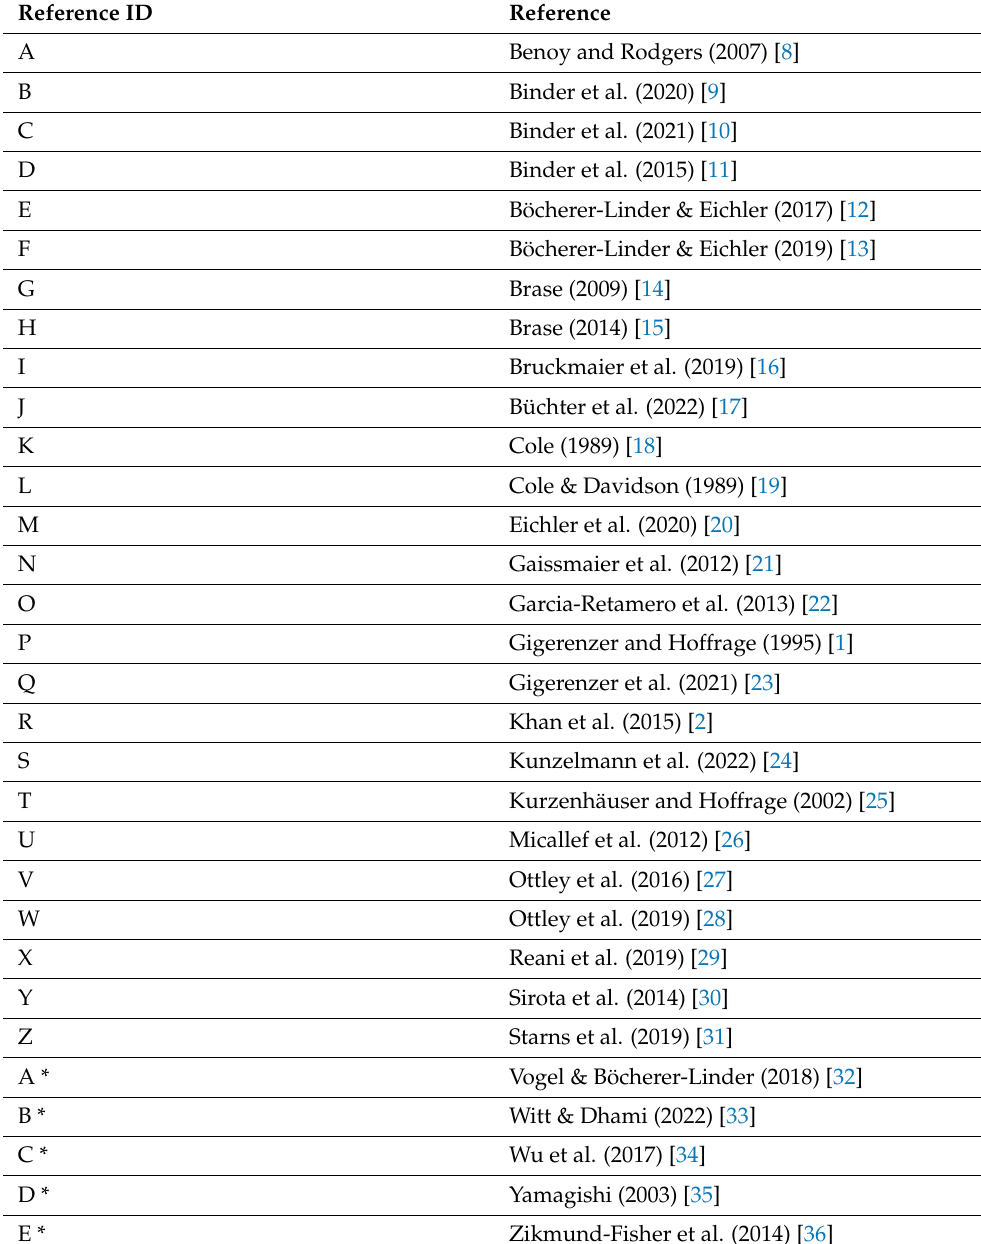
Table 1. References corresponding to articles outlined in Figure